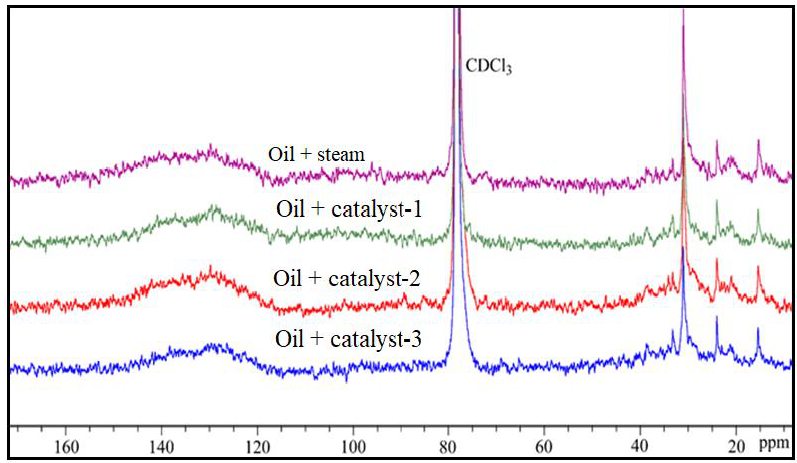
Figure 11. 13 C NMR spectra of asphaltene fractions of original and upgraded oil.